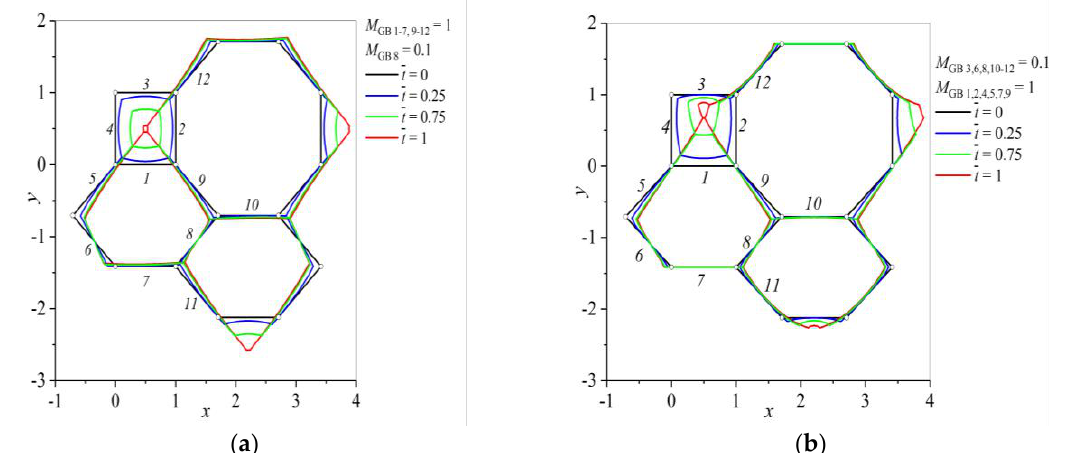
Figure 12. Evolution of the grain arrangement for different normalized times t . ( a ) Case XIII: The mobility of grain boundary 8 is reduced; M GB 8 is set to 0.1 and the remaining grain boundary mobilities M GB 1–7,9–12 are set to 1. ( b ) Case XIV: The mobilities M T 1–8 are set to value 100, grain boundary mobilities of the six sided grain III M GB 3,6,8,10–12 are set to 0.1 and the remaining grain boundary mobilities M GB 1,2,4,5,7,9 are set to 1.